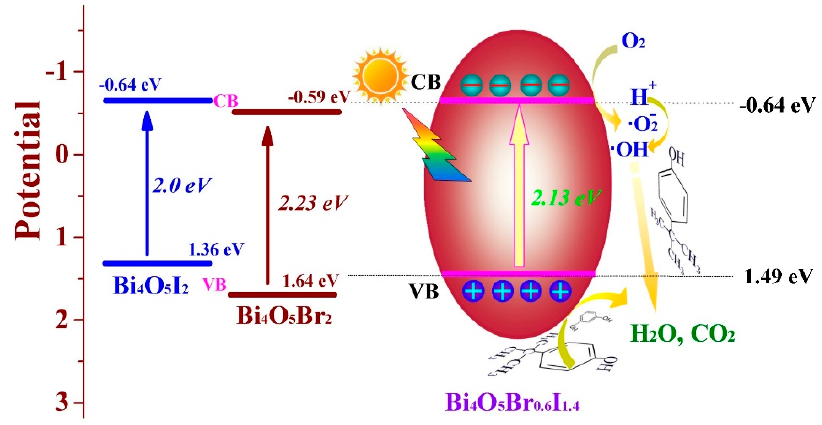
Figure 11. Mechanism for the photocatalytic degradation of phenolic compounds in the presence of Bi 4 O 5 Br 0.6 I 1.4 under visible light [116]. Copyright Elsevier 2018.